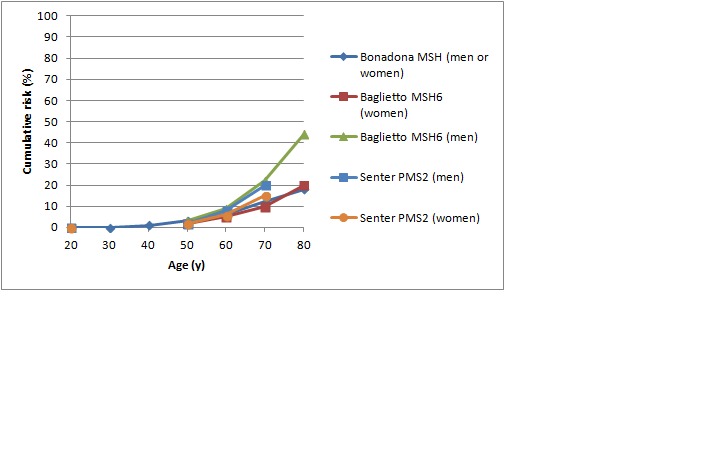
Studies shown: Bonadona,46 Baglietto,53 Senter52